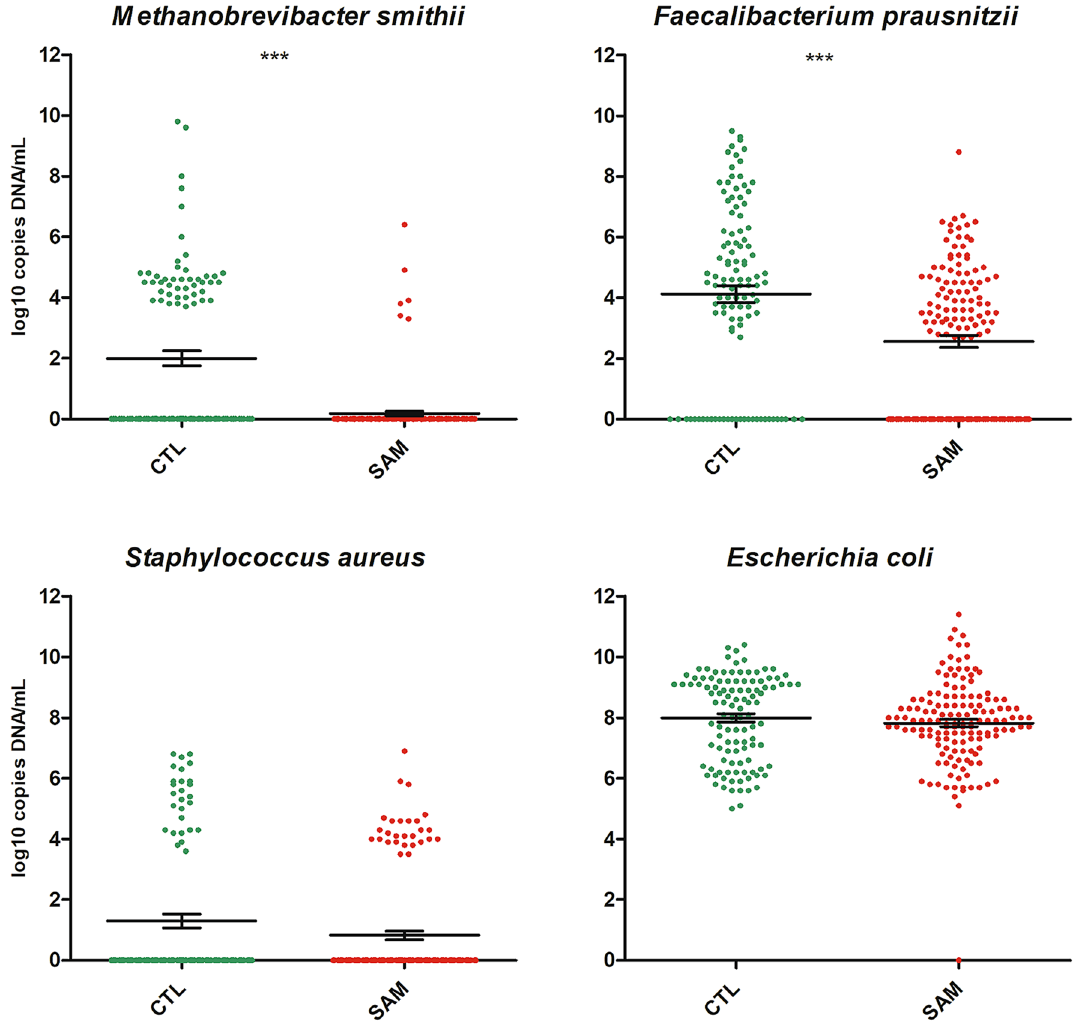
Figure 2. Absolute concentration of Methanobrevibacter smithii and other keys species. Species were quantified using real-time PCR in all samples and compared between healthy controls (green points) and children with severe acute malnutrition (red